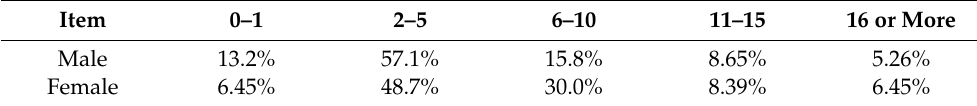
Table 12. Relationship between gender and frequency of shopping